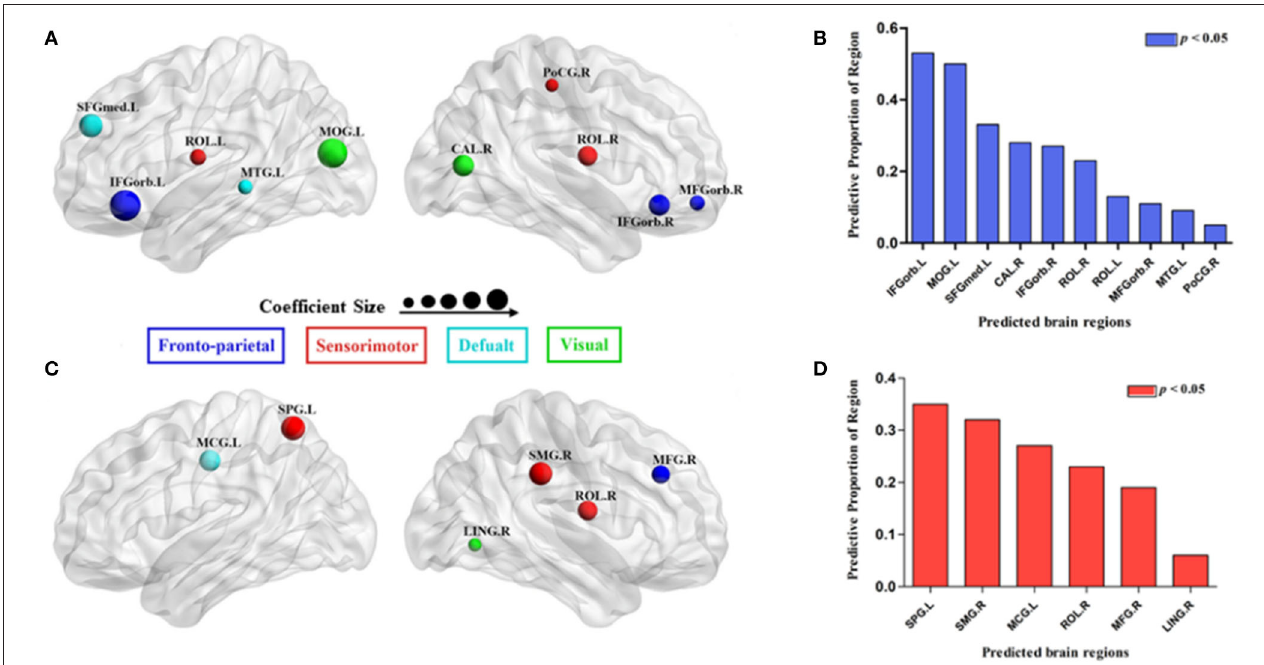
FIGURE 4 | Surface visualization of the brain regions that significantly predicted the integrated network parameters of the creative-network ( A for integrated local efficiency; C for integrated global efficiency); the model related to each region was significant ( p < 0.05; B for integrated local efficiency; D for integrated global efficiency). The radius of the node corresponds to the coefficient size. The different colors of the regions indicate different